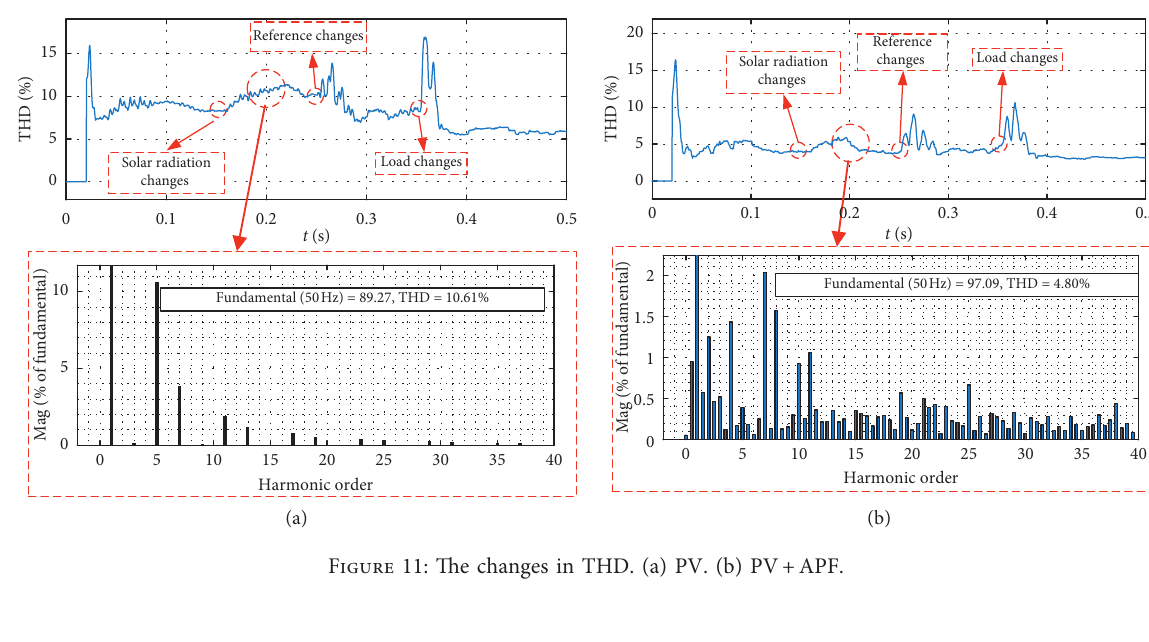
Figure 11: The changes in THD. (a) PV. (b) PV+APF.